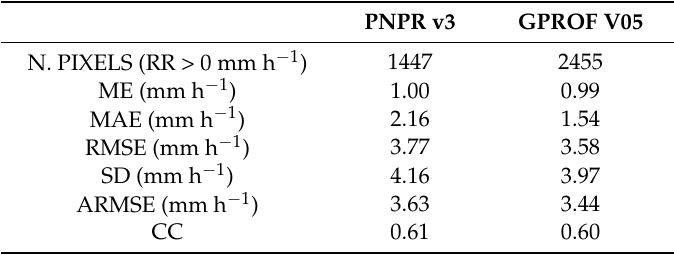
Table 8. Continuous statistical indexes (ME, MAE, RMSE, SD, ARMSE, CC) obtained, for PNPR v3 and GPROF V05 with respect to ground-based radar estimates, for the Livorno flash-flood case (GMI overpass at 01:17 UTC on 10 September 2017).